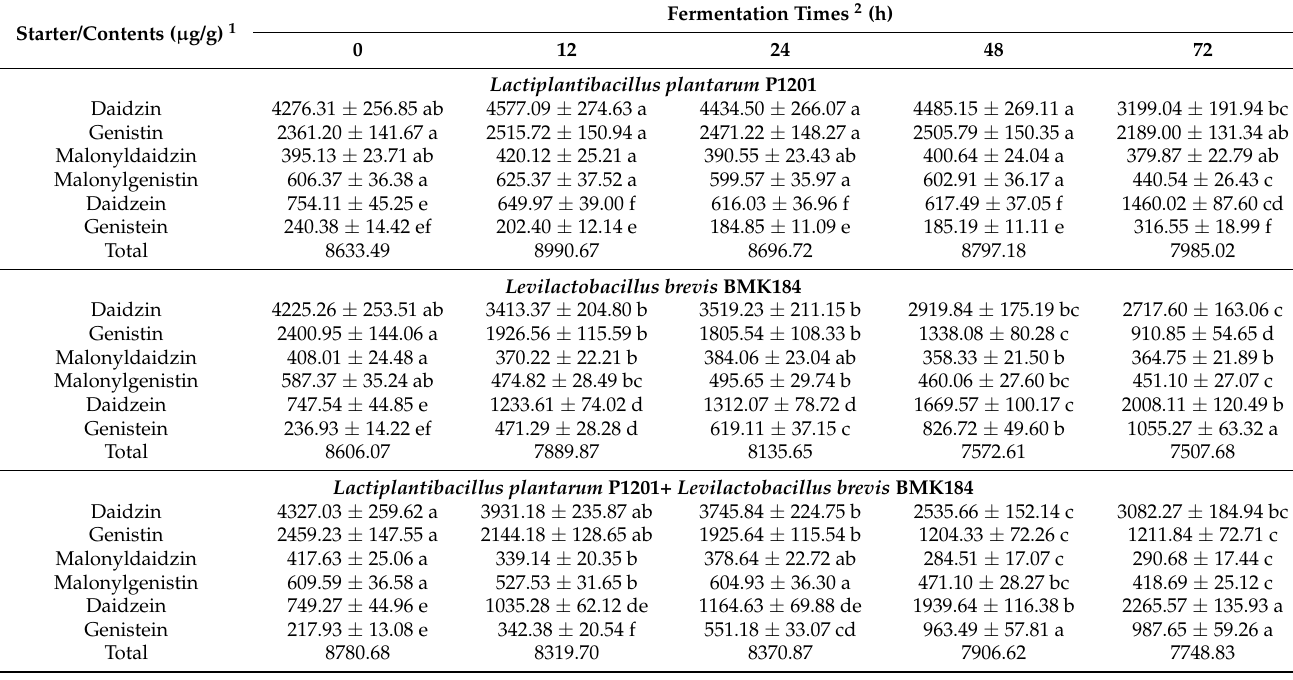
Table 4. Changes of isoflavone contents during the fermentation of isoflavone-enriched soybean leaves (IESLs) with the use of Lactiplantibacillus plantarum P1201 and/or Levilactobacillus brevis BMK184 as